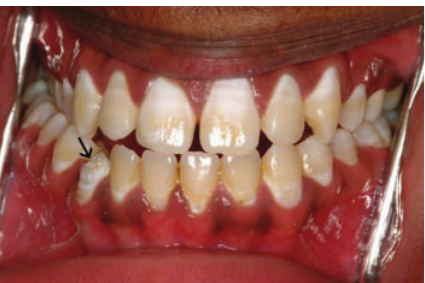
Figure 1: Before treatment: intra-oral views showing hypoplastic LR3.